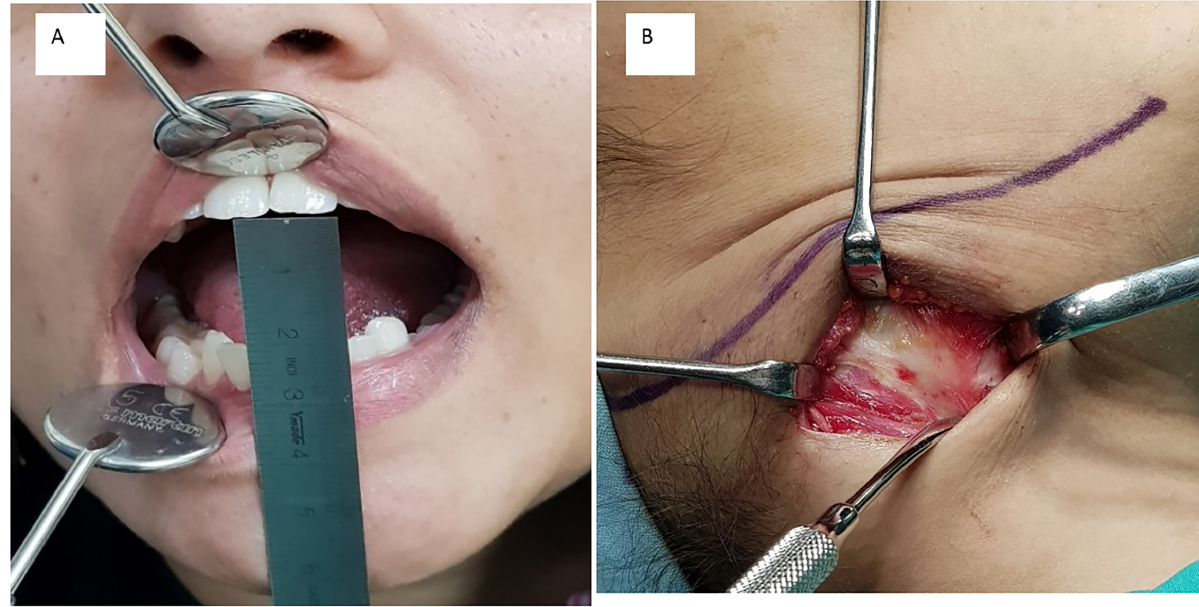
Fig. 1. Pre operative conditions. A: Limited mouth opening of 21mm; B: Aponeurosis of masseteric